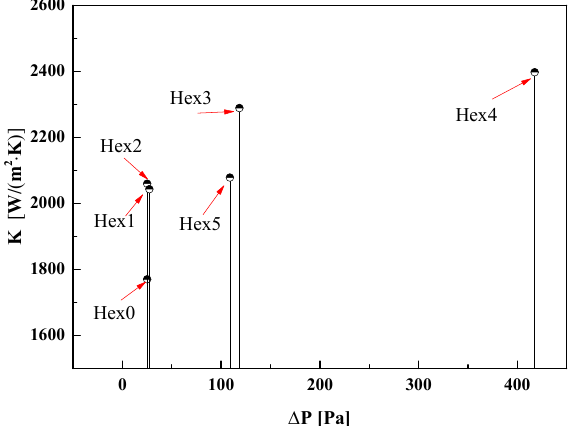
Figure 12. Average pressure drop. The heat transfer coefficients and pressure drops of Hex0~Hex5 are shown in Figure 13. The heat transfer coefficient of Hex3 is 2288.76 W/(m 2 · K) and that of Hex4 is 2397.37 W/(m 2 · K), and the value of Hex4 is about 1.05 times that of Hex3, but the pressure drops of Hex4 is 3.52 times that of Hex3. Although the pressure drops of Hex0~Hex2 are smaller than the one of Hex4, their heat transfer coefficients are smaller than the one of Hex3. For the heat exchanger, the heat transfer coefficient has a greater impact on the heat transfer performance than the pressure drop. The heat transfer coefficient of Hex4 is 1.35 times, 1.16 times, 1.17 times and 1.15 times that of Hex0, Hex1, Hex2 and Hex5, respectively. Considering the pressure drop and the heat transfer coefficient, for the aircraft, the optimal design structure of the water evaporator is Hex4. Hex4 has the largest heat transfer coefficient and smallest weight, which can decrease the structure and weight and reduce the weight compensation of the aircraft.